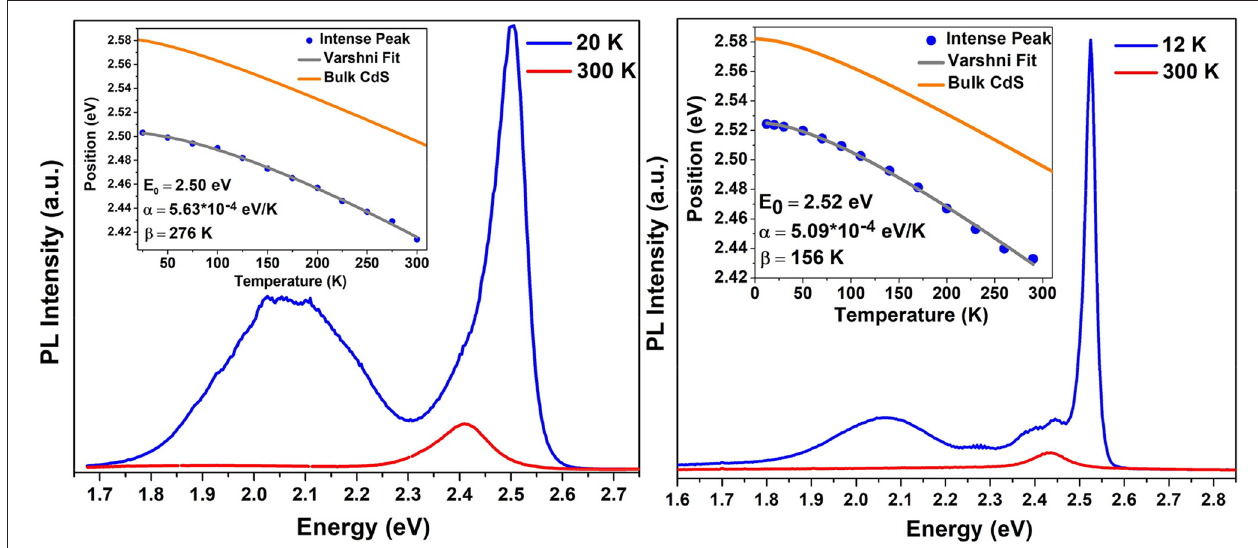
FIGURE 6 | Photoluminescence spectra at low and room temperature of (A) sample A and (B) sample B. In the inset, the fit of the NBE peak to the Varshni equation and the obtained parameters are